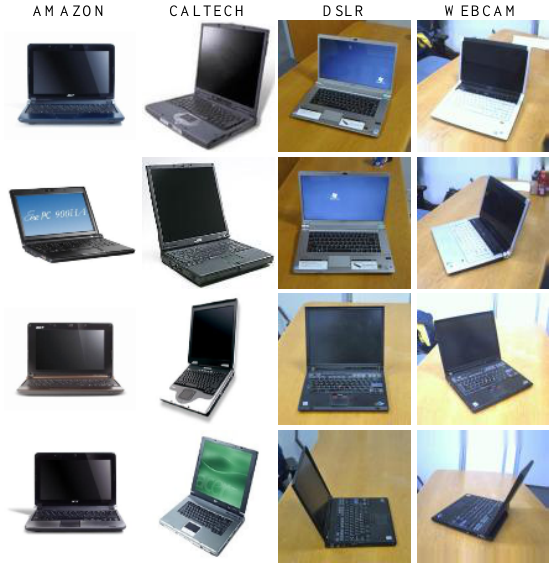
Figure 4. Laptops in different